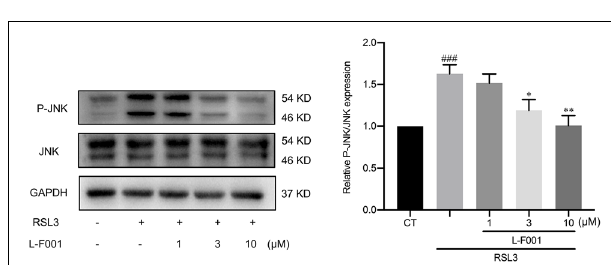
FIGURE 5 | L-F001 inhibits RSL3-induced JNK activation in HT22 cells. HT22 cells were treated with 0.1 µ M RSL3 alone, and then added L-F001(1–10 µ M) at 37 ◦ C for 24 h. The levels of P-JNK and JNK were measured by Western blot, and the amount of P-JNK and JNK were estimated by densitometric analysis of each protein band ( n = 3). ### P < 0.001 compared with the control group. * P < 0.05 and ** P < 0.01 compared with the RSL3